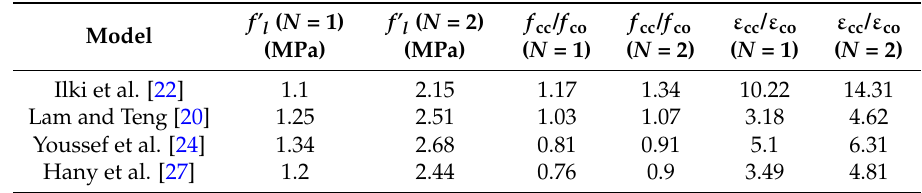
Figure 9. Axial stress-strain relationships for CFRP-jacketed columns obtained from model predictions: ( a ) one ply; ( b ) two plies. Table 7. Main parameters calculated for the investigated models.